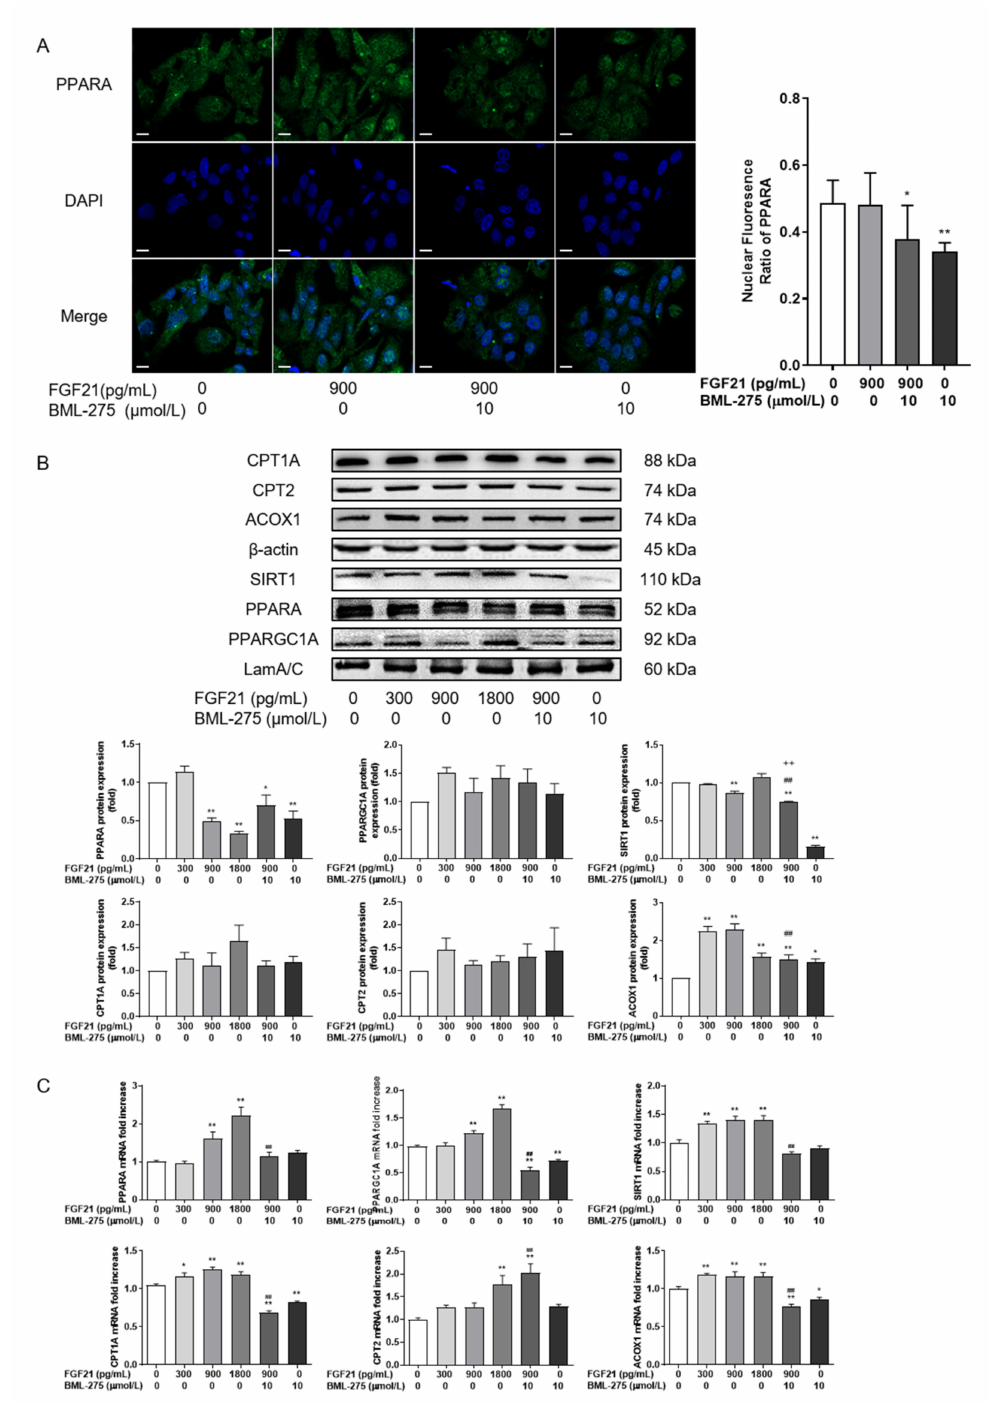
Figure 4. FGF21 promotes the expression of key proteins in intracellular fatty acid oxidation. Hep- atocytes were treated with FGF21 and BML-275 individually or in combination for 4 h. ( A ) Im- munofluorescence staining was conducted to determine the effect of FGF21 or BML-275 on PPARA nuclear translocation in hepatocytes ( left ). Green, PPARA staining; blue, DAPI nuclear staining (630 × ). Fluorescent intensity from 4 randomly selected microscopic fields per group ( right ). ( B ) West- ern blot analysis of PPARA, CPT1A, CPT2, ACOX1, PPARGC1A and SIRT1. ( C ) Relative mRNA expression levels of PPARA, CPT1A, CPT2, ACOX1, PPARGC1A and SIRT1. Three independent experiments were performed. Statistical significance was indicated: *, p < 0.05; **, ++ and ## , p < 0.01; * was compared with control group, # was compared with 900 pg/mL group, + was compared with BML-275